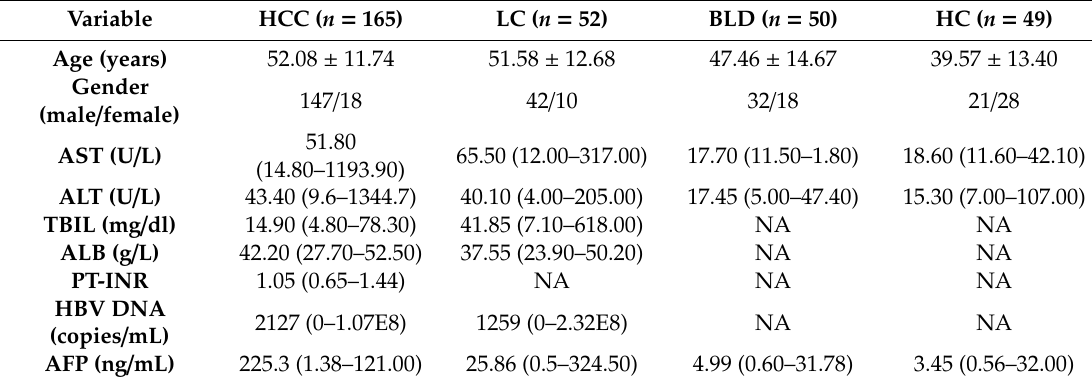
Table 6. Baseline characteristics of all the